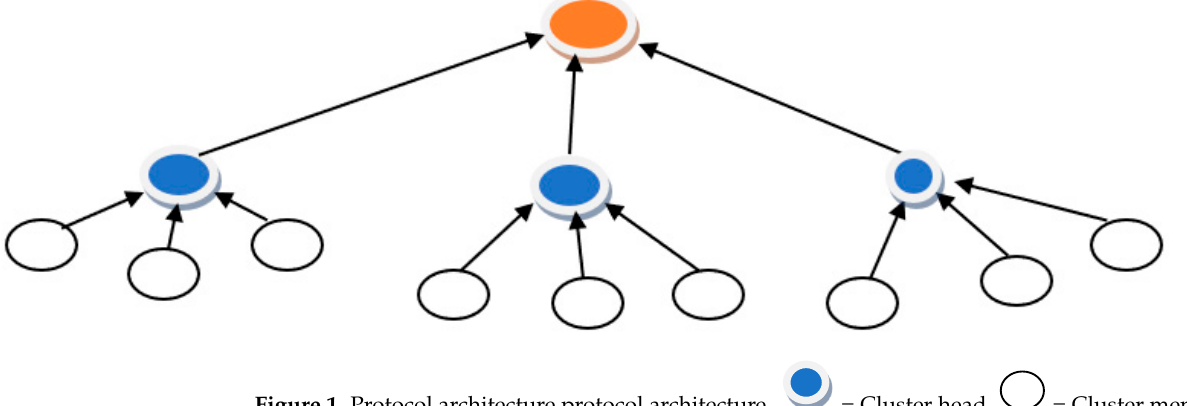
Figure 1. Protocol architecture protocol architecture. = Cluster head, = Cluster mem-